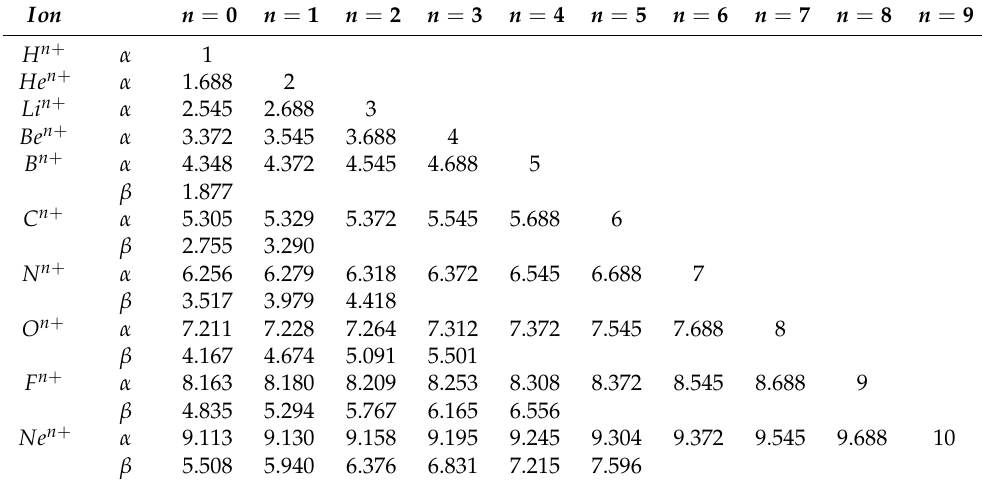
Table 3. Variational parameters α , β .